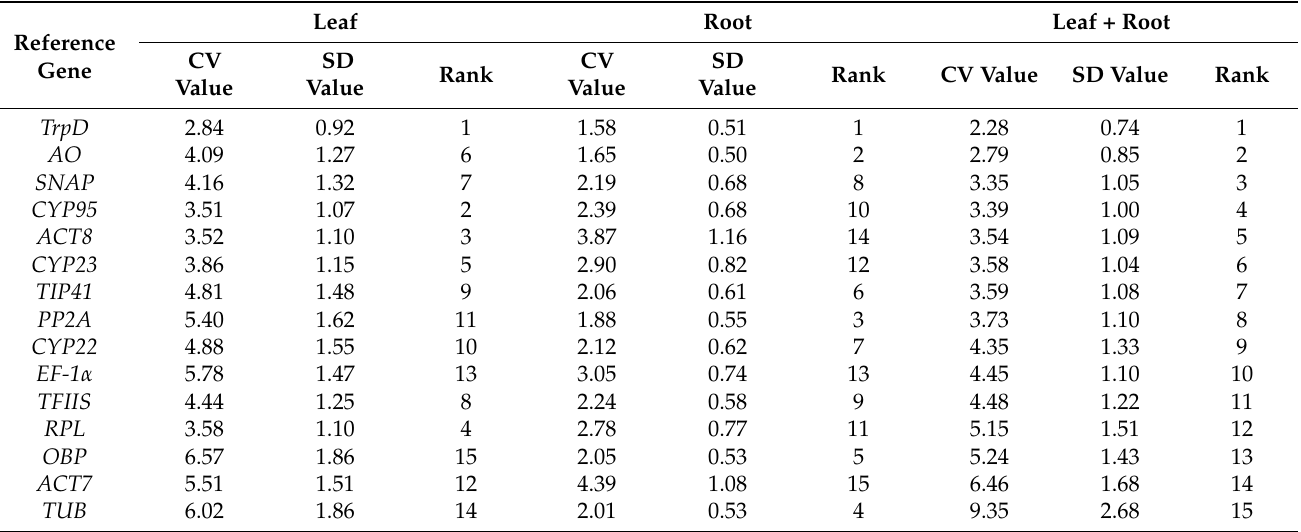
Table 4. Ranking of candidate reference gene stability by BestKeeper analysis.